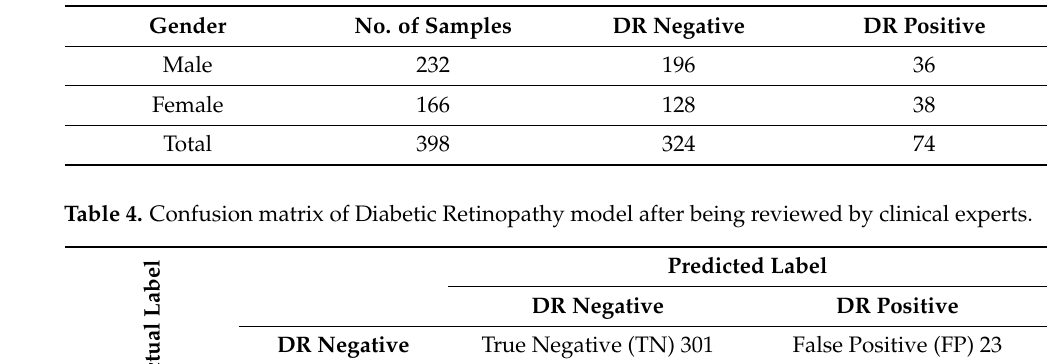
Table 3. Results of Diabetic Retinopathy model for data at SIOVS.